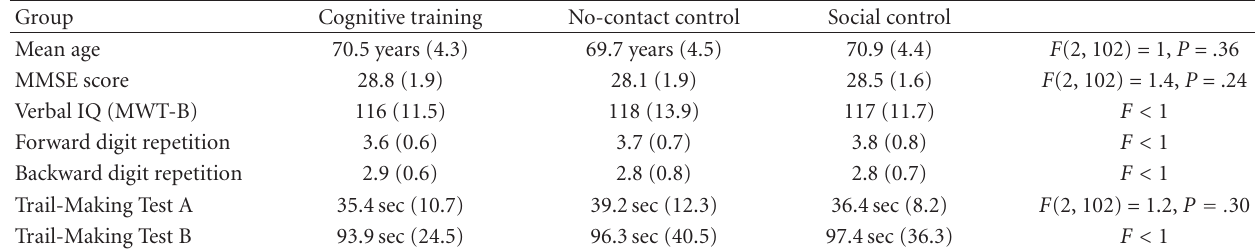
Table 1: Demographic characteristics and cognitive status of the participant groups (Mini Mental State Examination, verbal IQ, forward and backward digit span, and Trail-Making Test A and B). Standard deviations are given in parentheses behind the mean values. There were no significant group di ff erences as is indicated by the statistical analyses (last